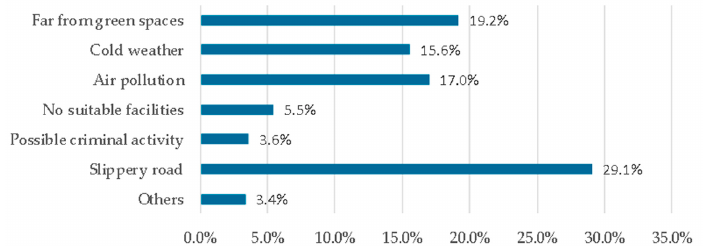
Figure 3. Factors hindering consistent exercise in the green spaces.